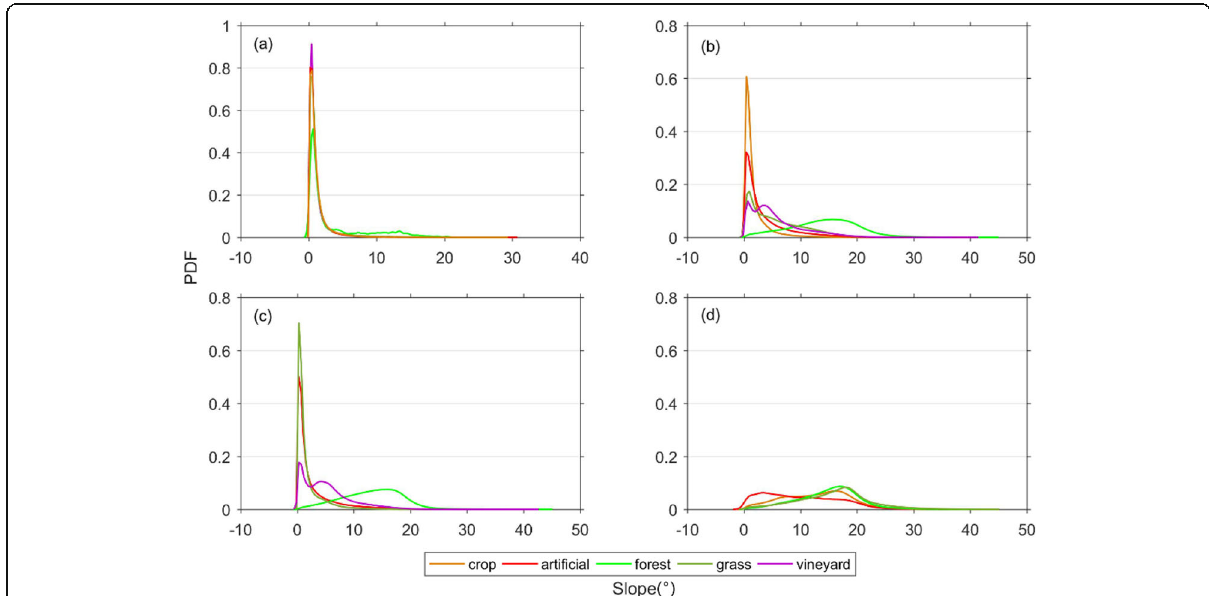
Fig. 8 The PDFs of the slope with different land covers in the four study areas: a floodplain, b plain to hilly, c hilly, d mountain. The vineyard in plain to hilly ( b ) and hilly ( c ) areas present bimodal